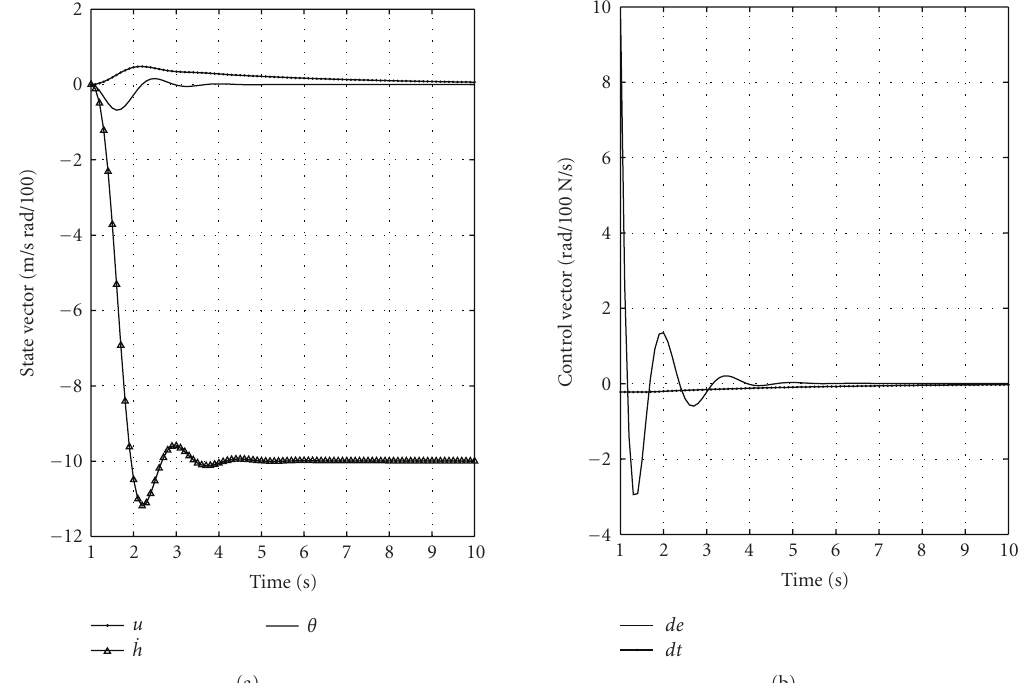
Figure 5: Time history of the kinematic variables (a) and of the control vector components (b) during a Cessna Citation simulated descent.